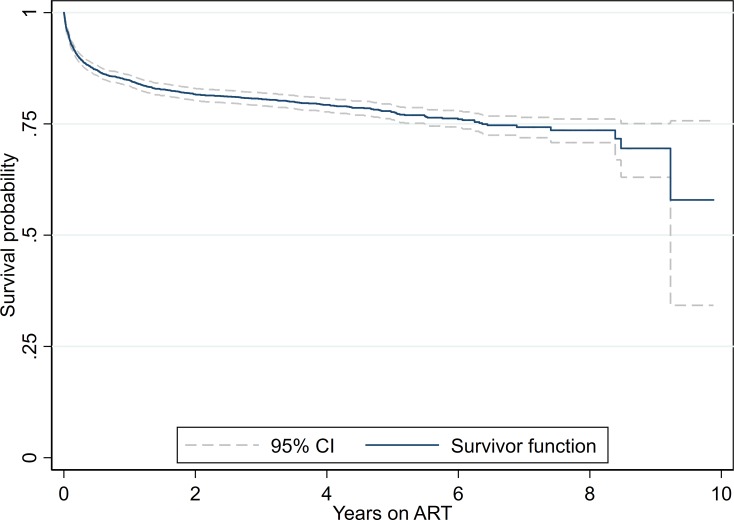
Kaplan-Meier survival curve of adult PLHIV on ART (N =
3,365).